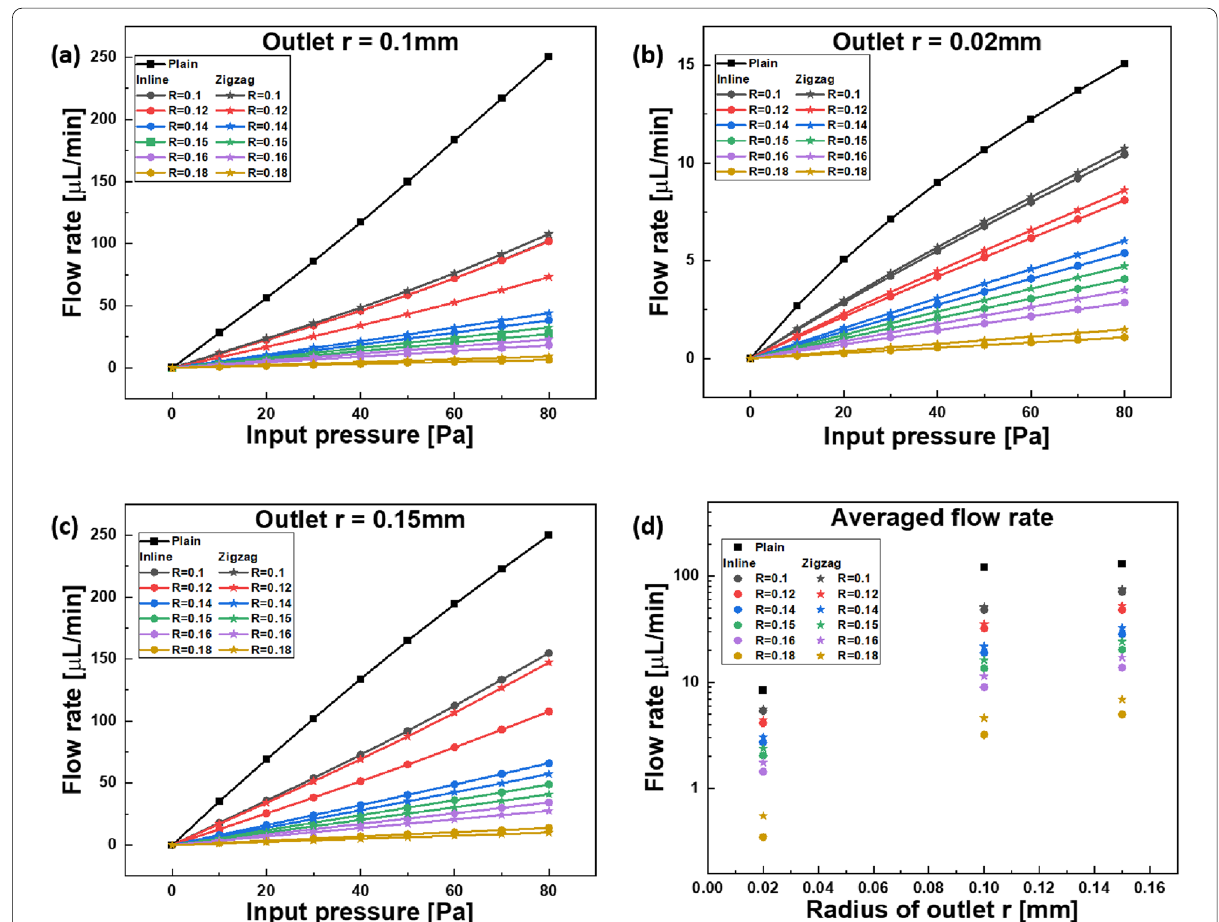
Fig. 4 Simulated results of flow rate at the outlet in microfluidic channel designs. a – c The flow rates with different radii of crater‑shaped structures (R) at a fixed radius of the outlet (r). d The average flow rate of the fluid decreases according to the increased radius of the crater‑shaped